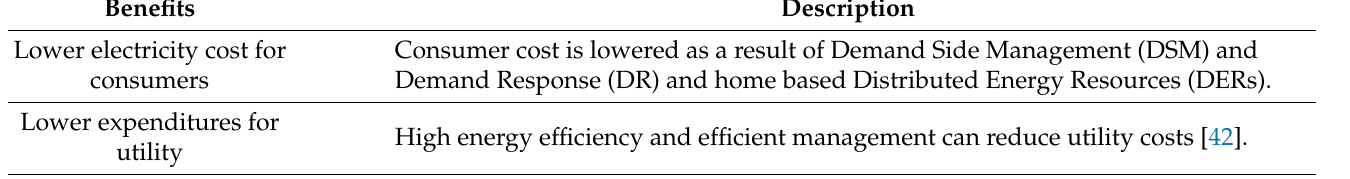
Table 3. Summary of the benefits of smart power management schemes in the OIC countries. Benefits